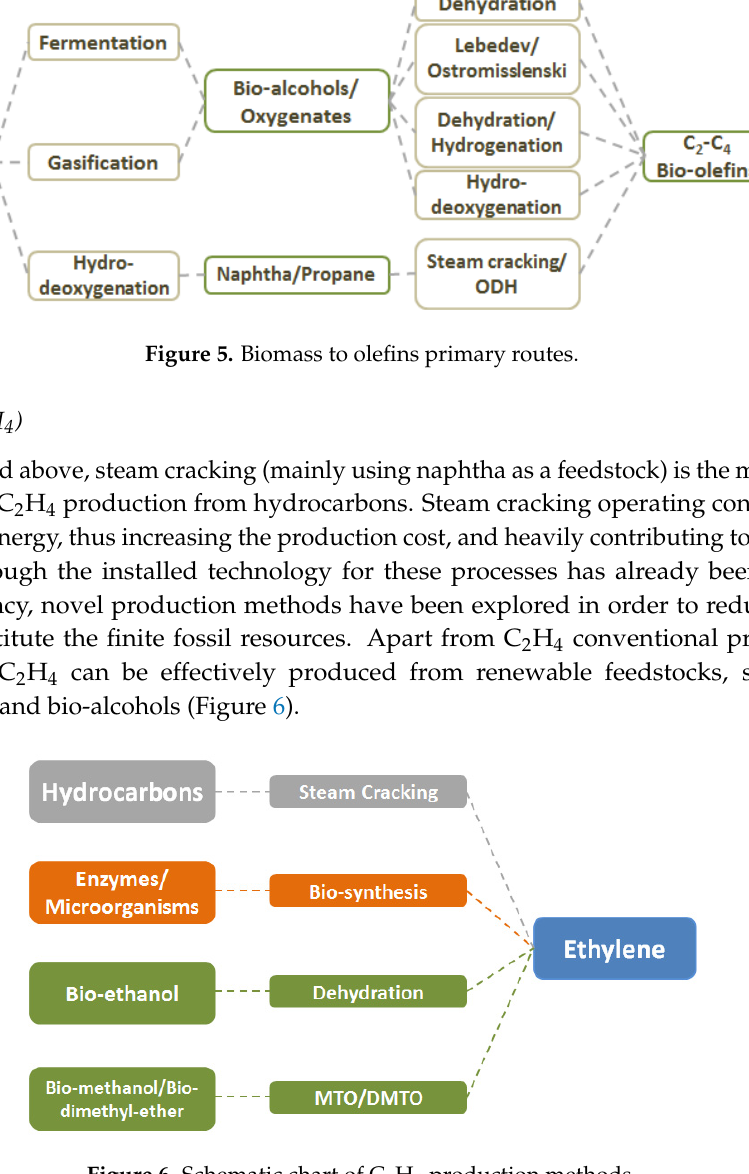
Figure 6. Schematic chart of C 2 H 4 production methods.